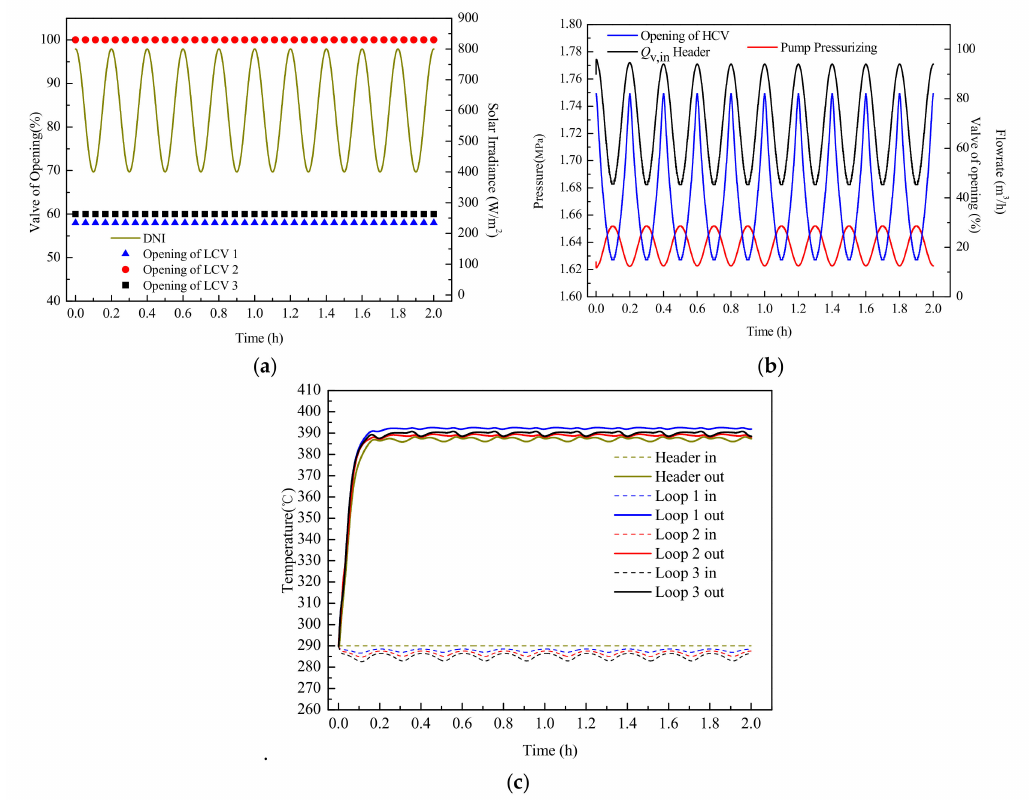
Figure 18. Header control valve (HCV) control for: ( a ) Initial parameters and DNI disturbance; ( b ) Results of HCV opening, header inlet flow rate, and pump pressurizing; ( c ) Results of inlet and outlet temperature of header and three